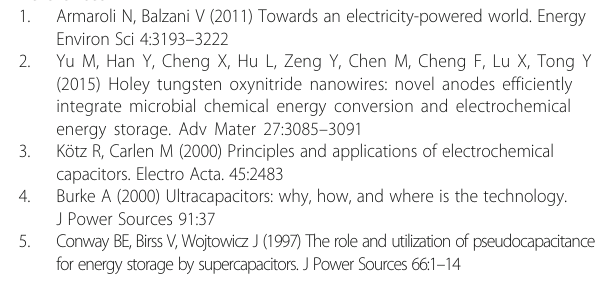
Additional file 1: Figure S1. Surface morphologies of ALD synthesized TiO 2 NMs with different ALD cycles: (a) 100 ALD cycles. (b) 200 ALD cycles. (c) 400 ALD cycles. Figure S2. Crystal structures of TiO 2 . (a) Diagram showing the arrangement of atoms in anatase and rutile phases of TiO 2 . (b) Standard XRD patterns of anatase TiO 2 (JPCDS # 21 – 1272) and rutile TiO 2 (JPCDS # 03 – 1122). Figure S3. XPS spectra of TiO 2 NMs with 100, 200, and 400 ALD cycles. To calibrate, C 1s peak is used as reference peak at binding energy of 284.6 eV. High-resolution XPS spectra of (a) Ti 2p and (b) O 1 s. The peaks at ∼ 464.9 and ∼ 459 eV is assigned to Ti 4+ 2p1/2 and Ti 4+ 2p 3/2 respectively. The peak at 529 eV is assigned to O 1 s. Figure S4. Electrochemical characterization of TiO 2 NMs. (a) and (c) CV curves of TiO 2 NMs with 200 and 400 ALD cycles at different scan